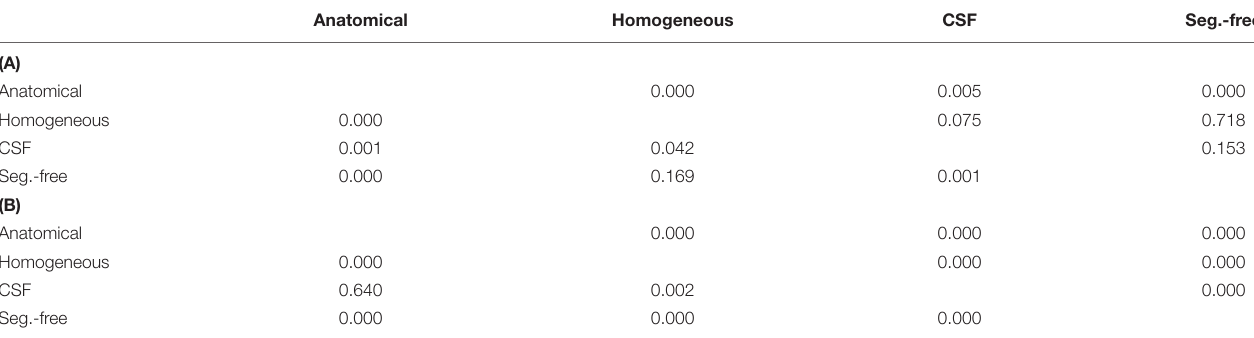
TABLE 5 | p -Values obtained from pairwise two-sample two-tail t -test for localization error with all SNR values shown in (A) Figure 4 and (B) Figure 7